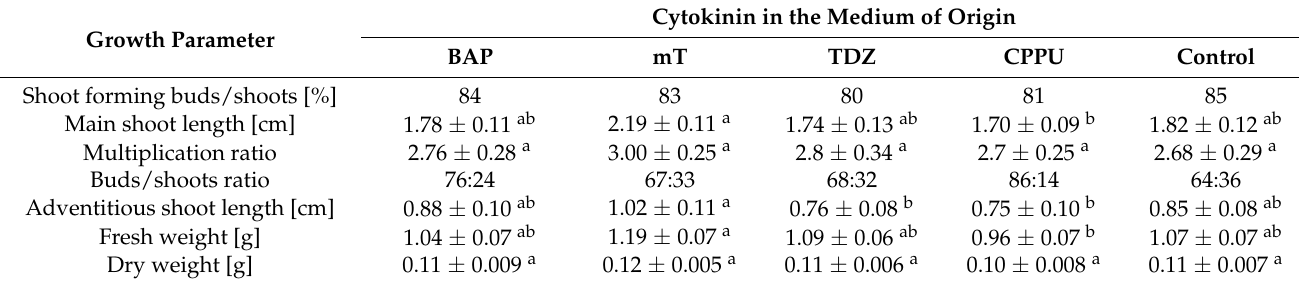
Table 3. Evaluation of morphogenic potential of S. bulleyana shoot lines obtained in the presence of different cytokinin and control shoot culture after year (passage